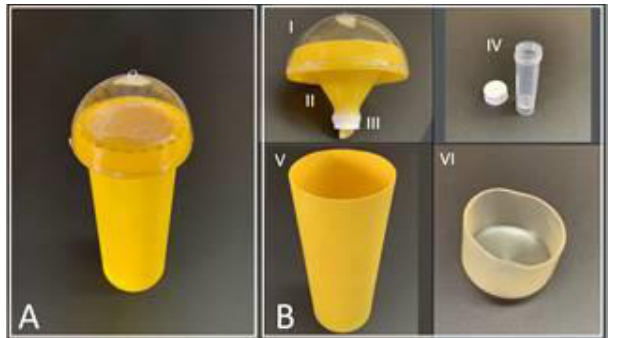
Figure 1. Stem trap. ( A ) Assembled stem trap used for the study. ( B ) Parts of the stem trap: I. Semi- circular, clear, plastic dome with an aperture at the top; II. Rain skirt; III. Funnel structure; IV. Funnel outlet for connecting the cap of the capture vial; V. Capture vial; VI. Body of the trap with stem-like protrusions on the outer surface leads to entry holes to guide ACPs into the trap ’ s interior; VII. Tripod structure; and VIII. Hanging nut used to deploy the trap and connect the tripod structure with the dome.